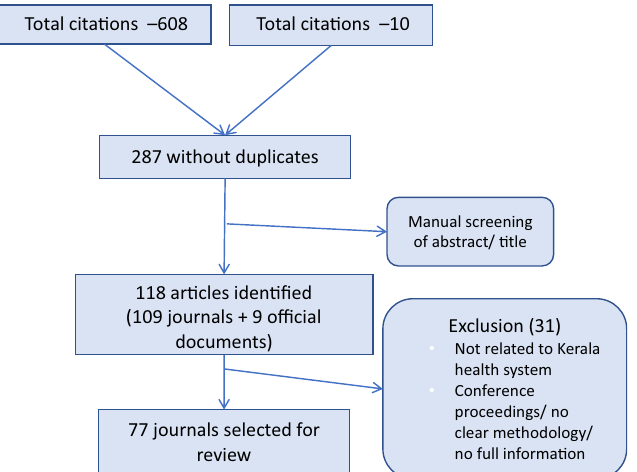
Figure 1. PRISMA flow